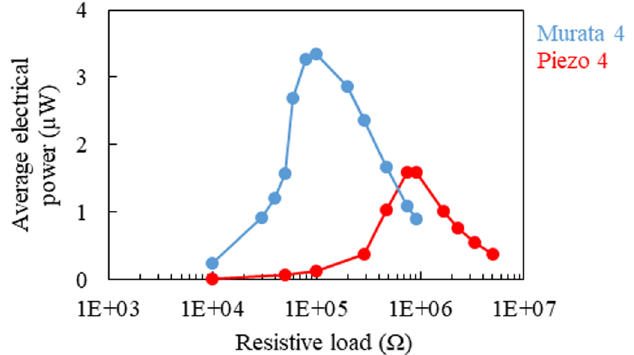
Fig. 13. Harvested electrical energy with a commercial piezo- electric transducer (in blue) and with our home-made one (in